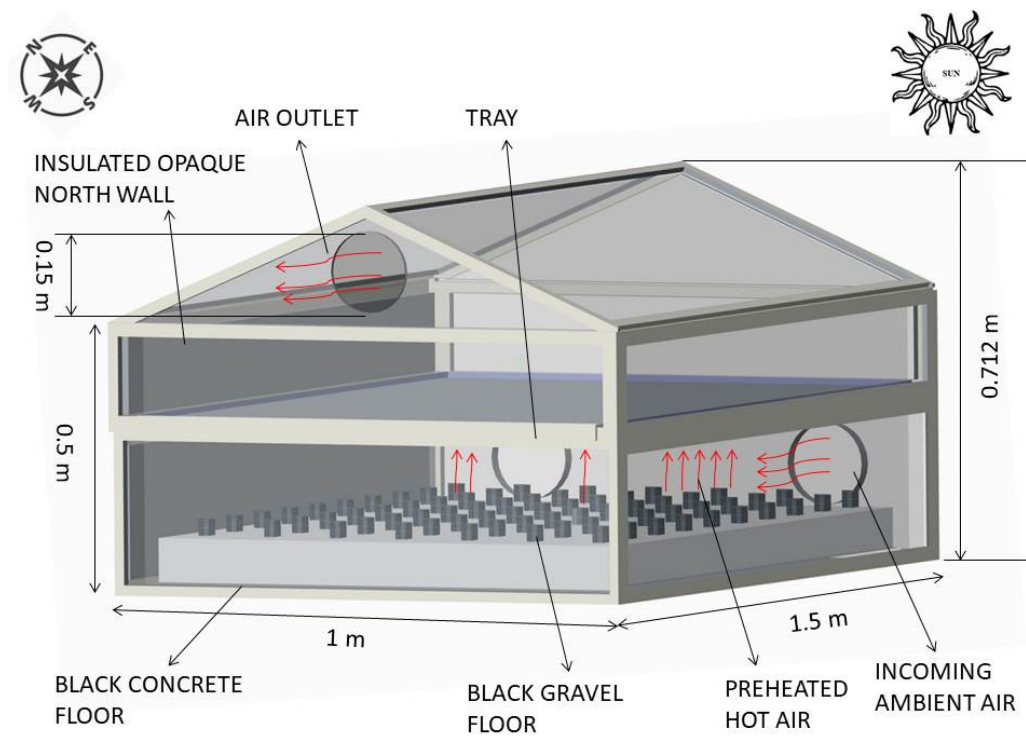
Figure 5. Pictorial view of a natural convection solar greenhouse dryer [52].